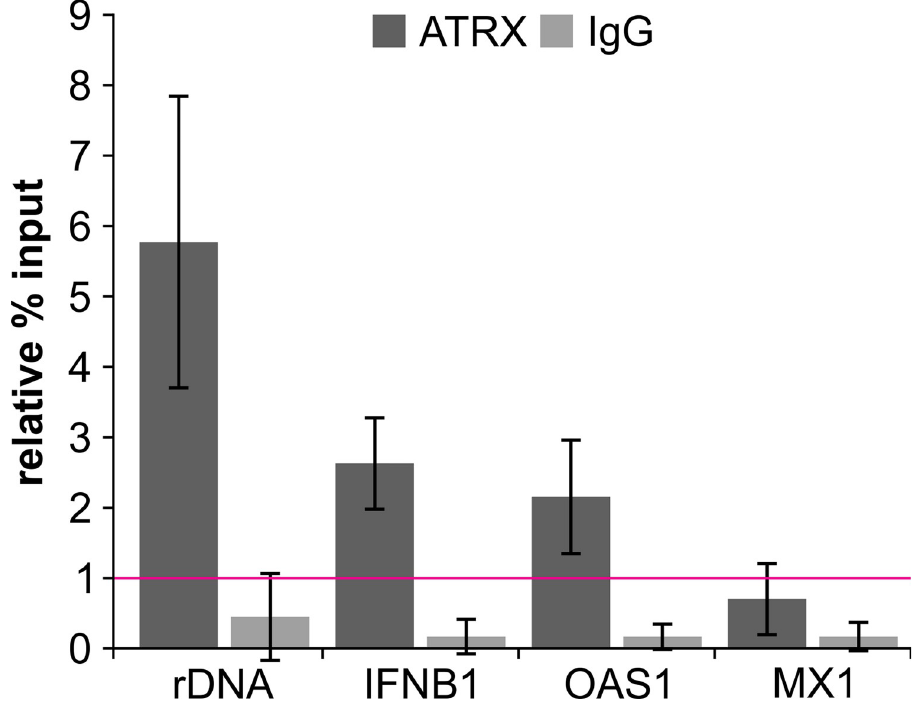
Fig 9. Enriched association of ATRX at target regions. HFFs were stimulated with 0.1 μ g/ml poly(dA:dT) for 16 h. Cells were fixed and subjected to ChIP with an anti-ATRX antibody (D1N2E) and IgG as control. Precipitation was analyzed by qPCR using primer pairs for rDNA (positive control), IFNB1 (promoter region), OAS1 (regulatory region), MX1 (regulatory region) and GAPDH (negative control). Results are shown as the percent of input immunoprecipitated by each antibody and normalized to the negative control (GAPDH), which was set to 1 (pink line). Depicted values were calculated from three independent experiments and are shown as mean ± SD.